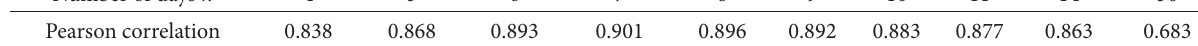
Table 1. Correlations between the subsurface temperature at a 30 cm depth and the average air temperature from the previous n days Number of days n